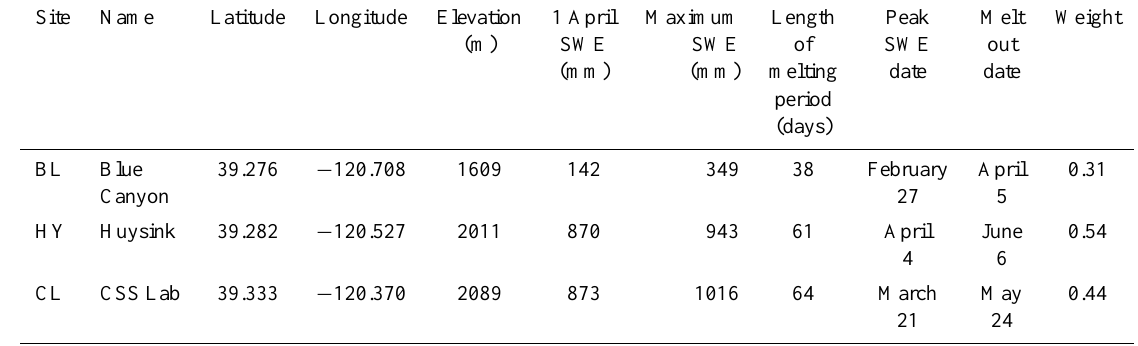
Table 2. Basic information for the three study snow stations and the corresponding weights used in determining the areal snow water equivalent.